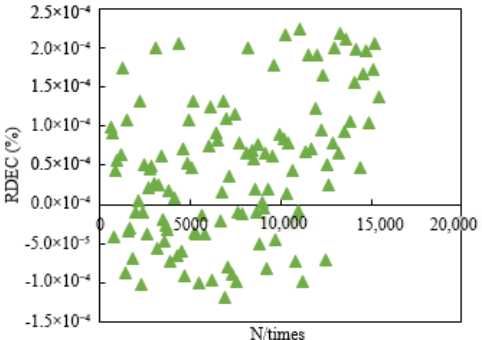
Figure 3. Evaluation result of N fm under strain ‐ control.